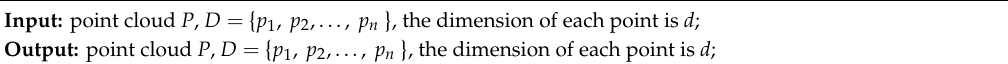
Algorithm A1: KNN-based local feature